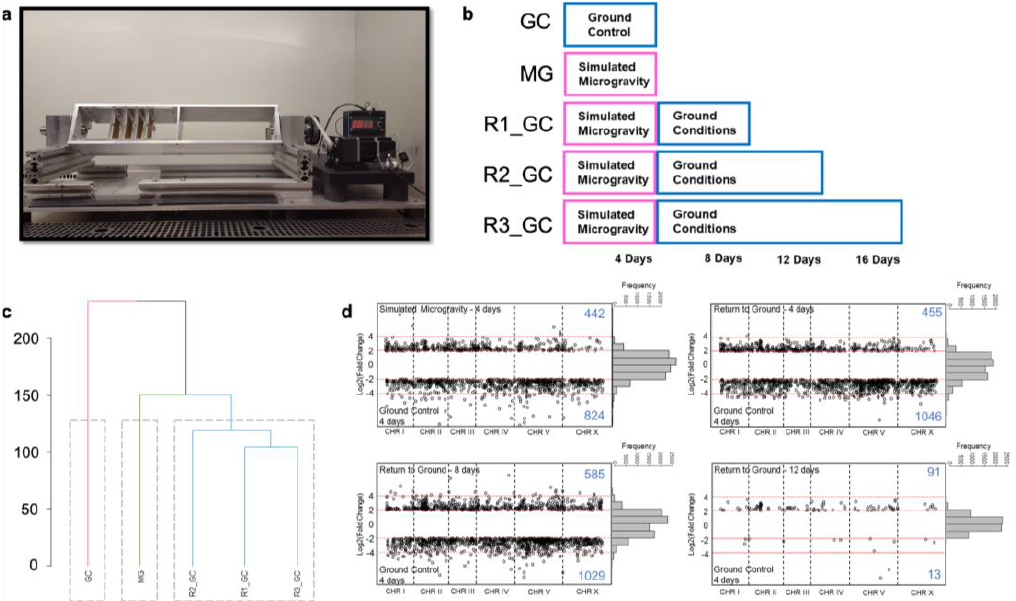
Figure 1. Transcriptomic response of C. elegans to simulated microgravity and return to ground conditions. ( a ) Clinostat used for simulating microgravity. ( b ) Experimental design for the effect of simulated microgravity on gene expressions during the exposure and after the return. ( c ) Dendrogram of the gene expression profiles for ground condition (GC), simulated microgravity (MG), four days after return to ground conditions (R1_GC), eight days after return to ground conditions (R2_GC), and twelve days after return to ground conditions (R3_GC). ( d ) Log2 fold change of the gene expressions (FPKM) between the conditions.